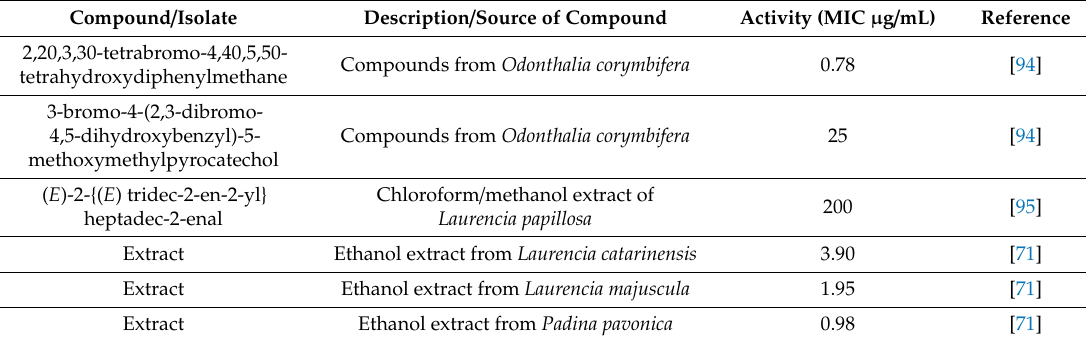
Table 4. E ff ective antifungal compounds / extracts against A. fumigatus from marine algae. Compound /